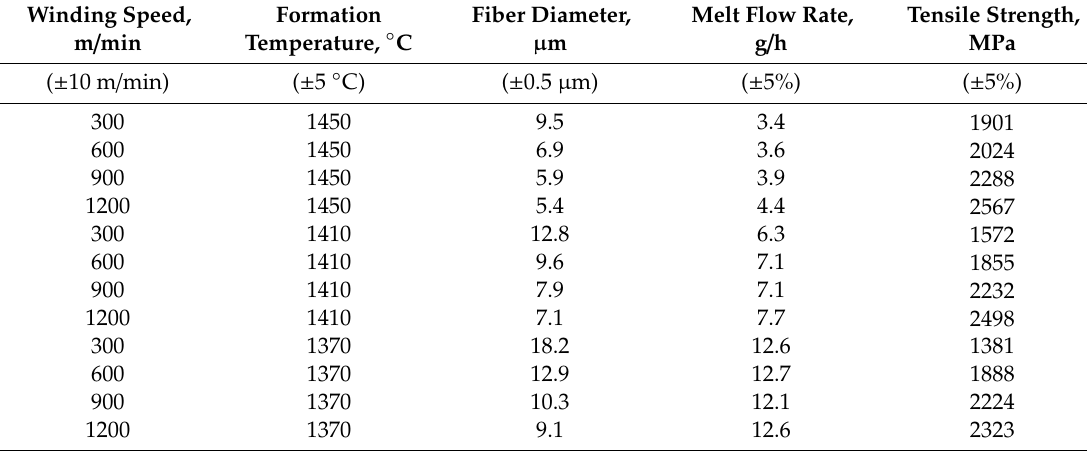
Table 3. Tensile strength of the fibers obtained under di ff erent process parameters using nozzle 3 (diameter 2.5